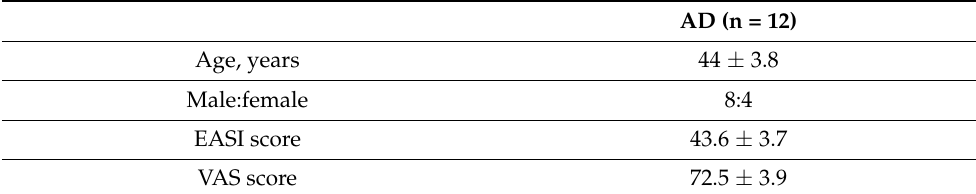
Table 1. Characteristics of study participants.